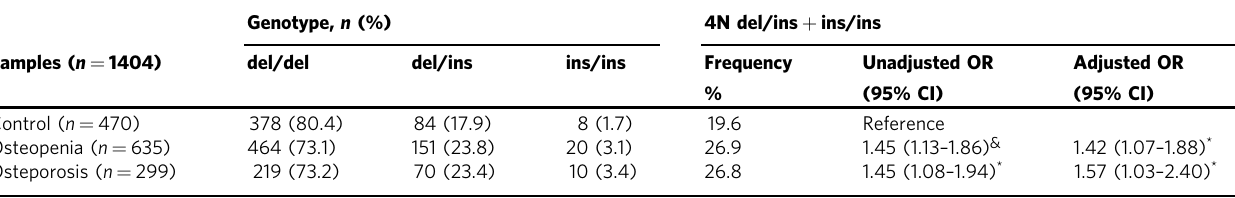
Table 1 Association between the -394 4N del/ins polymorphism of Ddah1 and osteoporosis, analyzed by logistic regression. Genotype, n